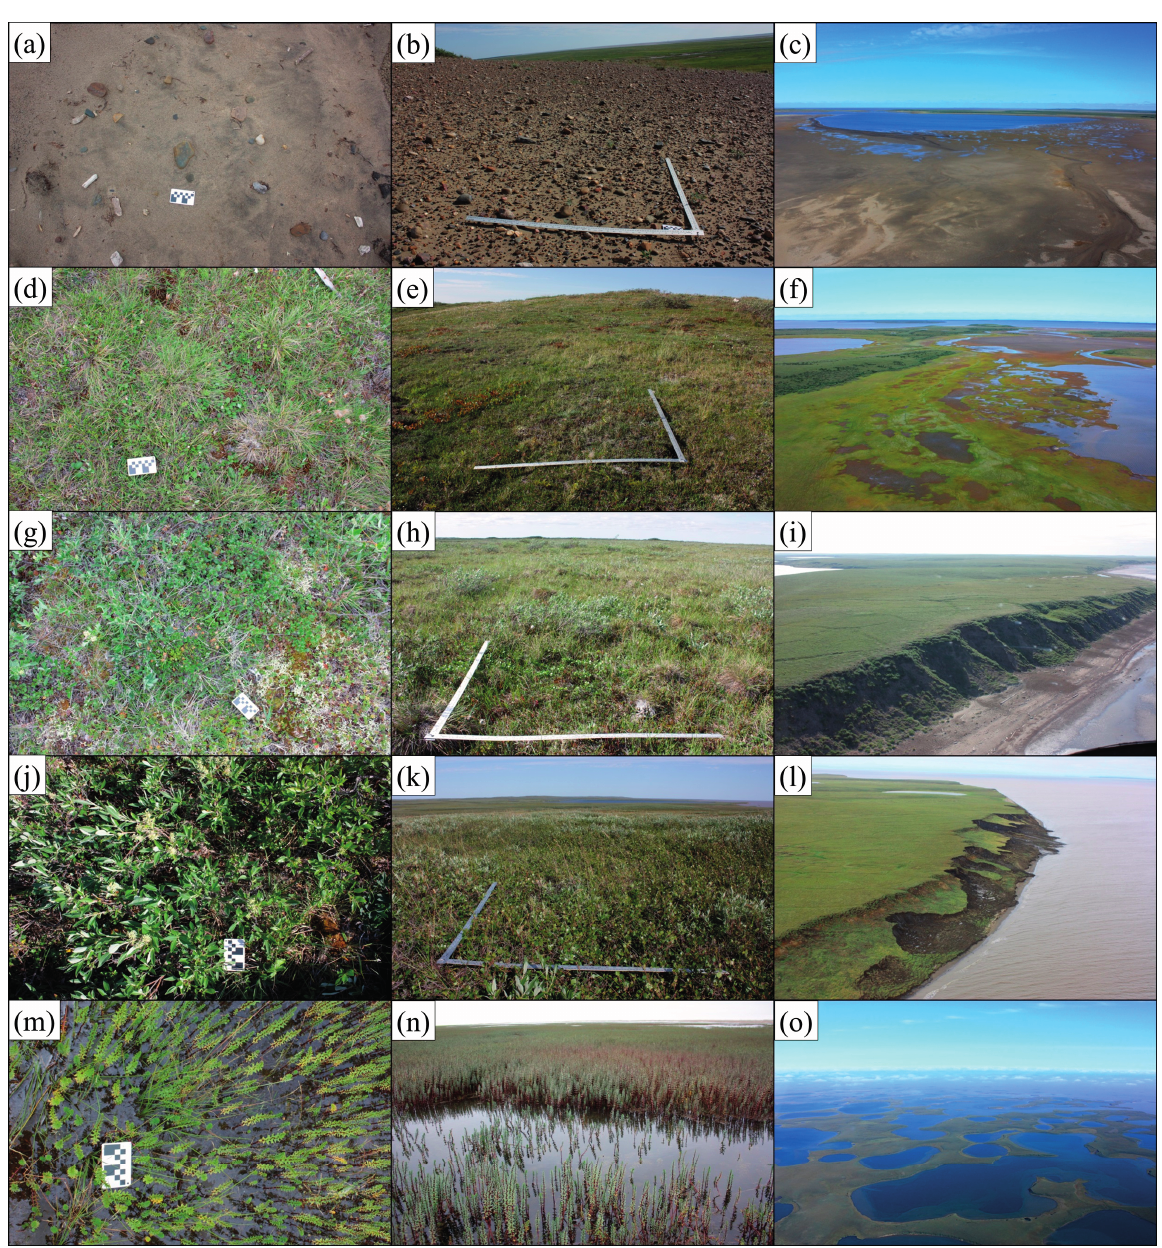
Figure 2. Field Photographs of Richards Island showing bare ground ( a , b ), coastal mudflat ( c ), low grass dominated tundra ( d , e ), coastal wetland ( f ), mixed tundra ( g , h ), coastal cliff with beach zone ( i ), shrub dominated tundra ( j , k ), coastal erosion slumps ( l ), wetland ( m , n ) and inland lakes ( o